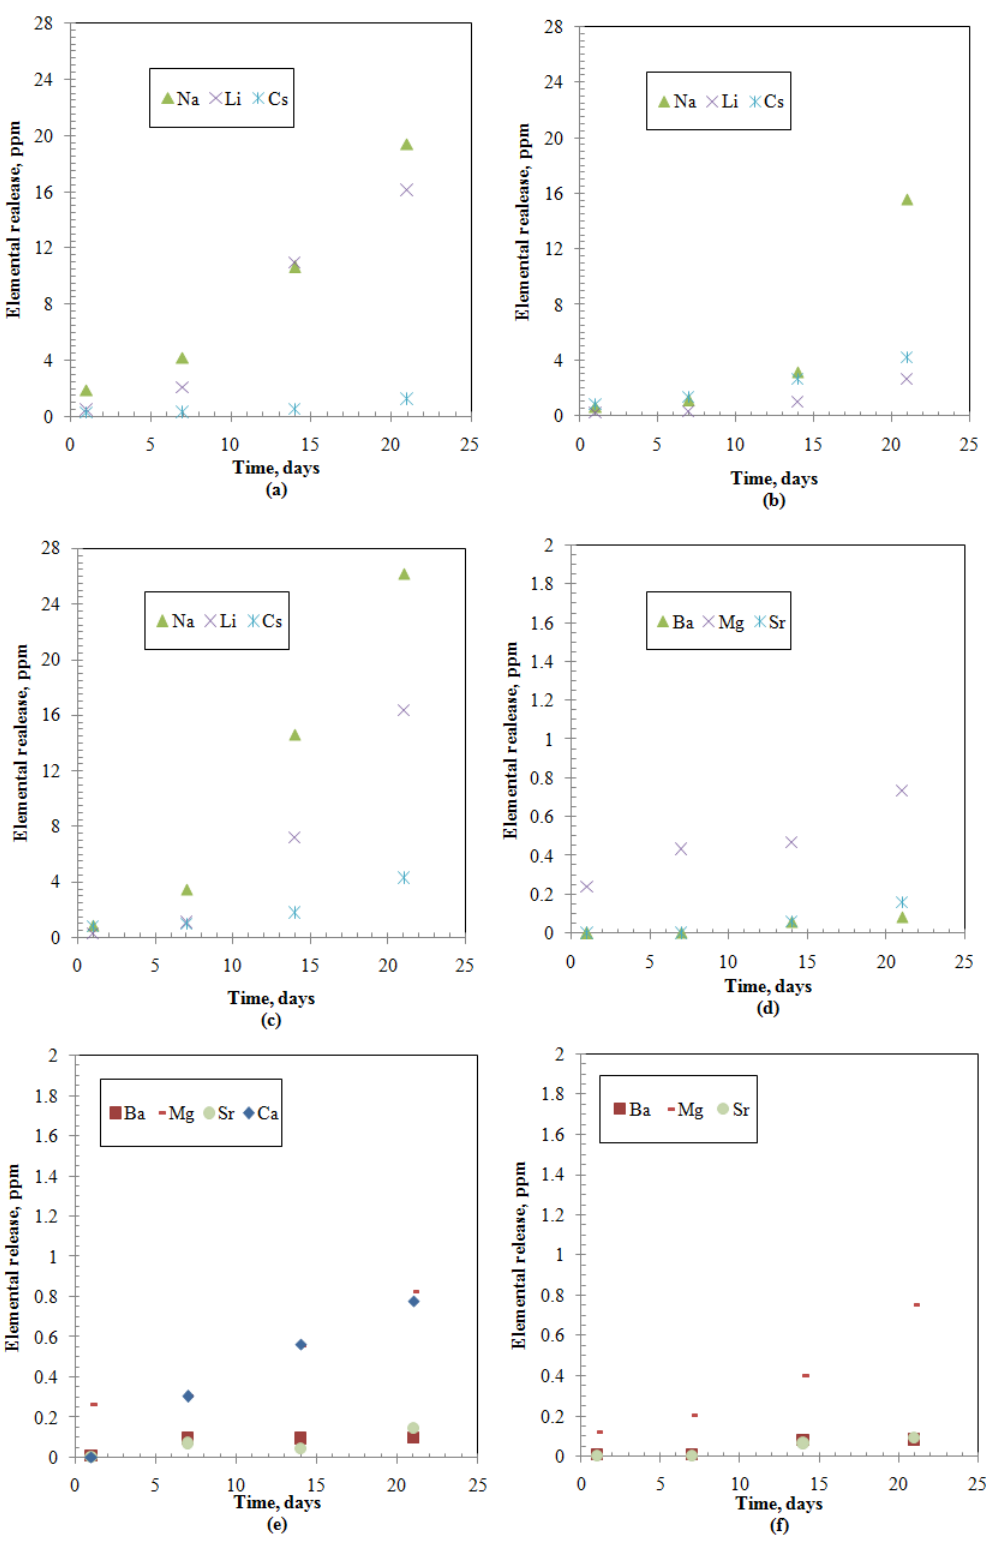
Figure 1. Elements releases from the studied samples: ( a ) Group I-Alkali-Borosilicate (ABS)-Waste (17); ( b ) Group I- Modified Alkali-Borosilicate (MABS)-Waste (20); ( c ) Group I-ABS-Waste (25); ( d ) Group II-ABS-Waste (17); ( e ) Group II-MABS- Waste (20); ( f ) Group II-ABS-Waste (25).